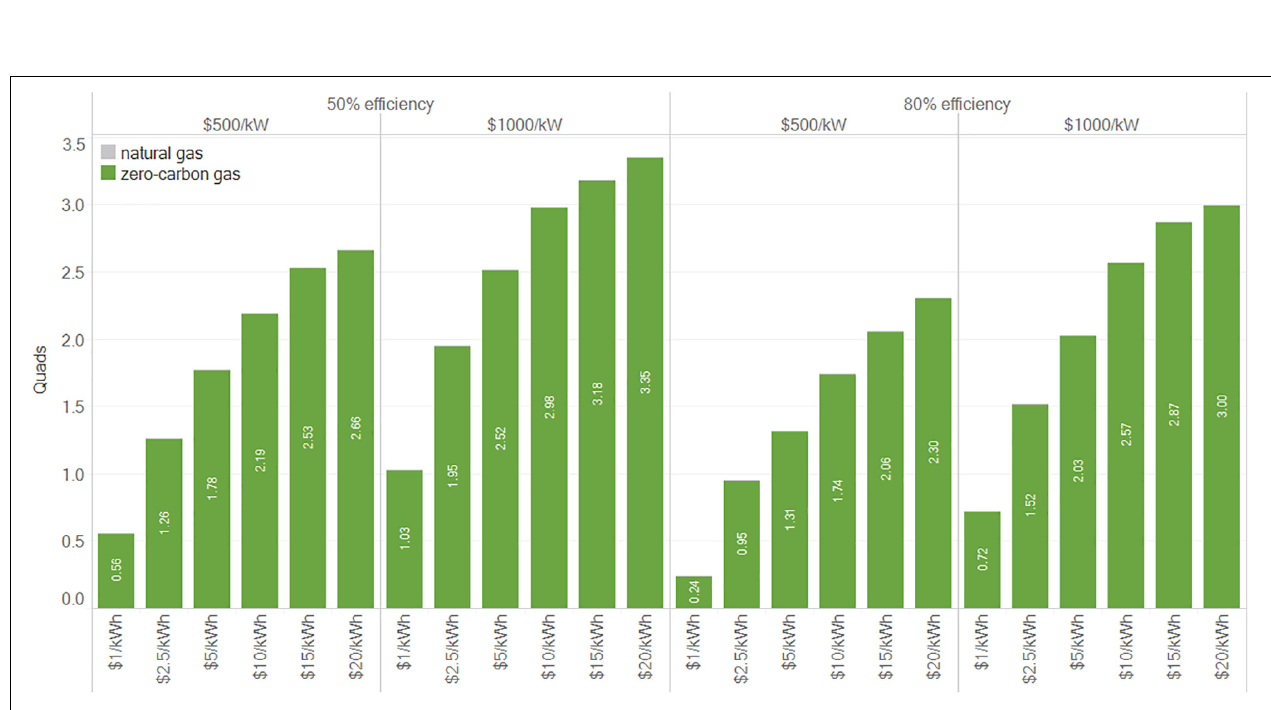
FIGURE 5 | Clean gas utilization in 2050 at different LTS costs ( top labels: efficiency and $/kW cost, bottom labels: $/kWh cost).